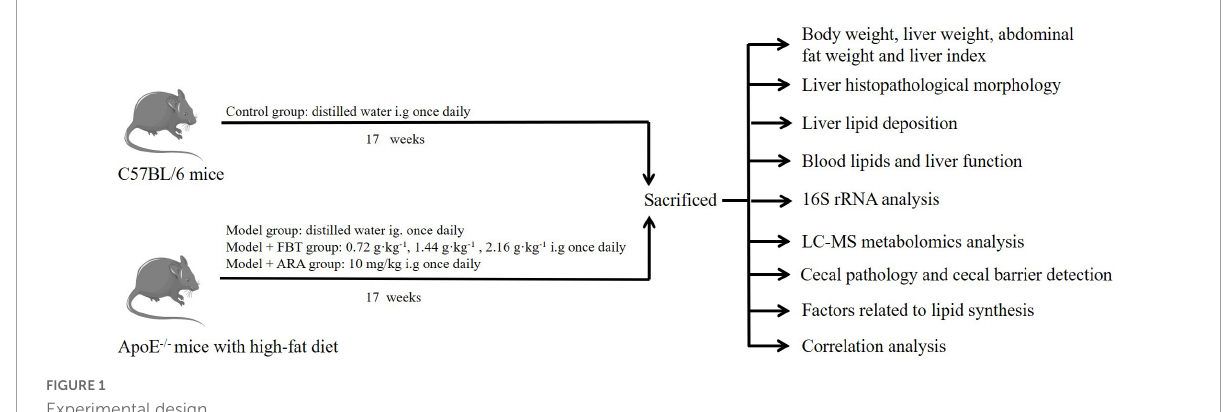
FIGURE1 Experimental